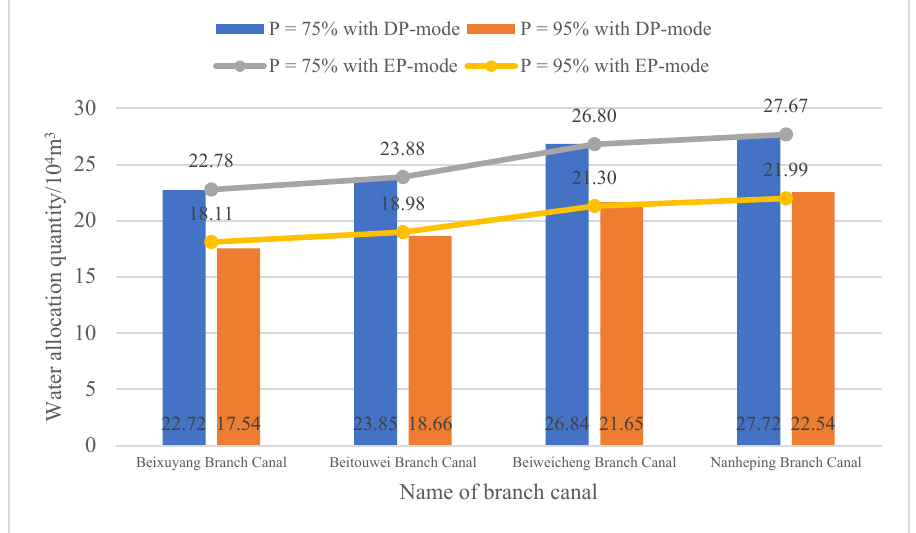
Figure 2. Comparison of the water quantity allocation for each branch canal for the two modes. Table 4. Optimal water quantity allocation of each branch canal in the Hengliu Main Canal system during the ponding period of rice in different year types using DP-mode.